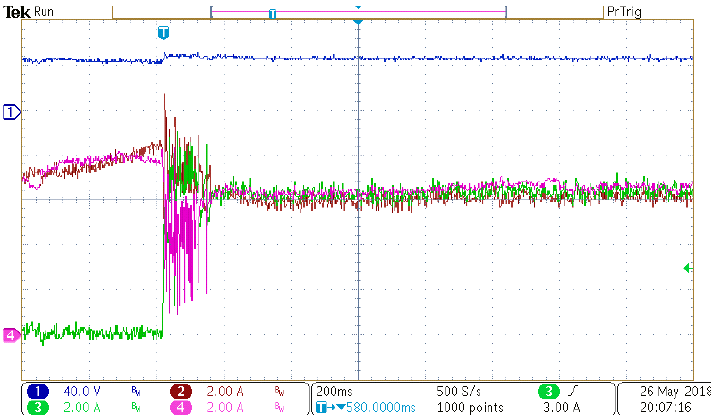
Figure 15. Experimental results from sequential switching of MASTER-voltage SLAVE-current control strategy ( P OUT = 35% to 15%).